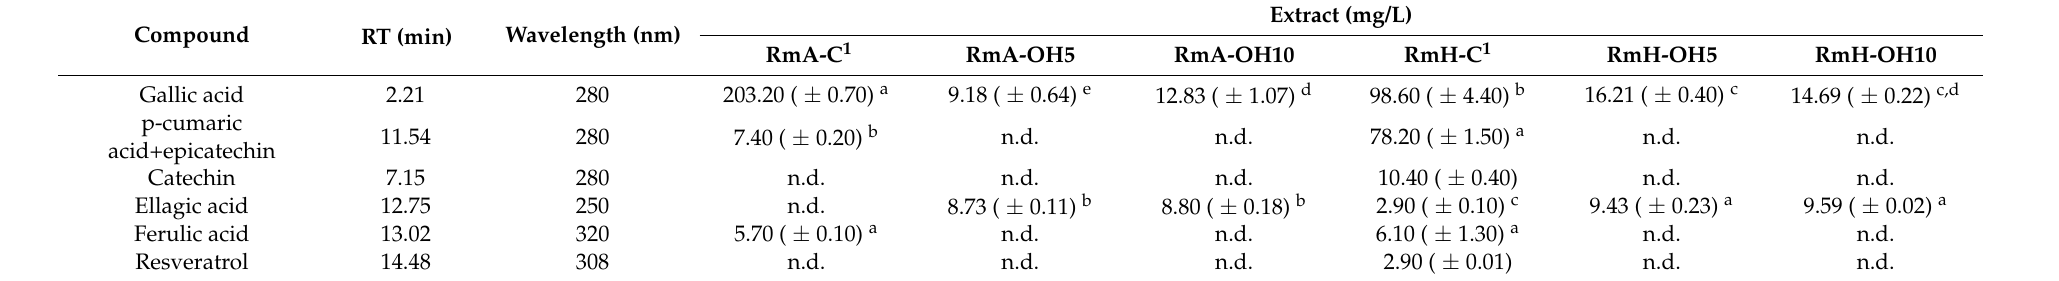
Table 3. Phenolic profile obtained by UHPLC of the different extracts of R. microphylla (Rm) fruits.